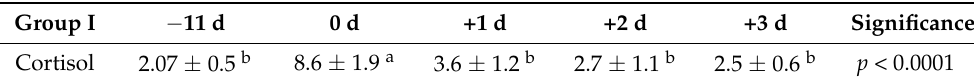
Table 9. The values represent the average and standard deviation from serum cortisol concentrations, assessed by the blood samples collected from animals of group I (1 to 15) at the moments − 11 d, 0 d, +1 d, +2 d, and +3 d. Statistical difference measured according to the Tukey–Kramer test—Beltsville, 2003. Group I − 11 d